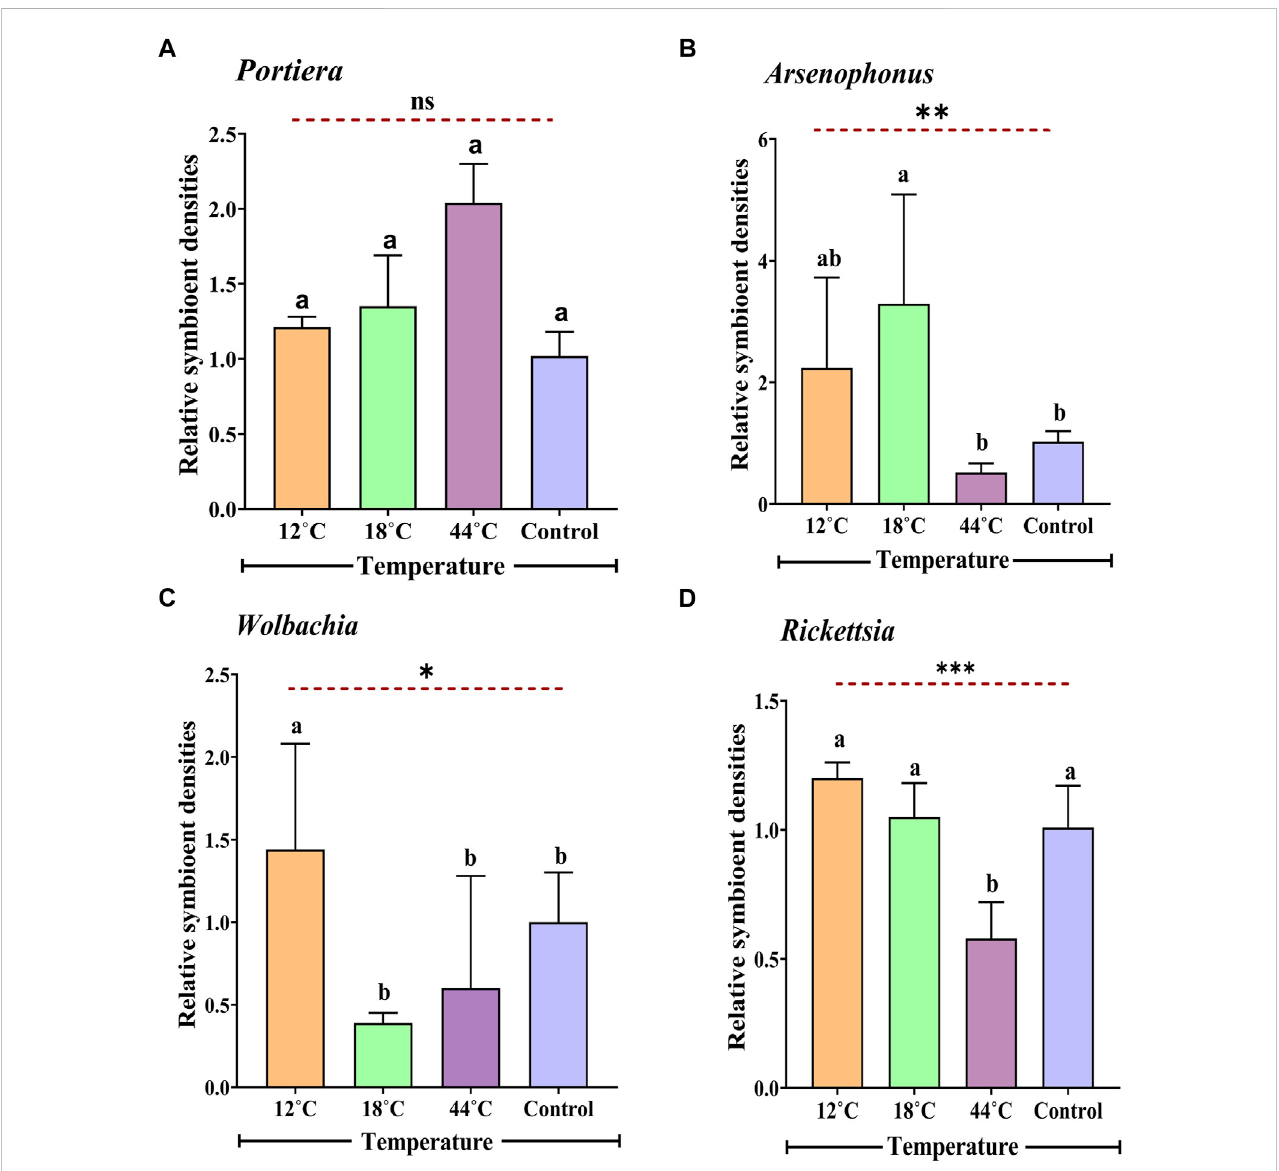
Relative titre of Portiera (A) , Arsenophonus (B) , Wolbachia (C) , and Rickettsia (D) in four different temperatures (12 ° C, 18 ° C, 26 ° C, and 44 ° C) B . tabaci populations as determined by quantitative PCR (normalized according to the amount of an actin gene). Adult white fl y exposed to 26 ° C was considered as control. Values for the relative amount of symbionts are means ± SEM of three replicates for each treatment. The data were analysed with one-way ANOVA. The different letters indicate statistically signi fi cant differences between the treatments. ns = non-signi fi cant, p ≤ 0.05 is indicated by *, p ≤ 0.01 is indicated by **, and p ≤ 0.001 is indicated by